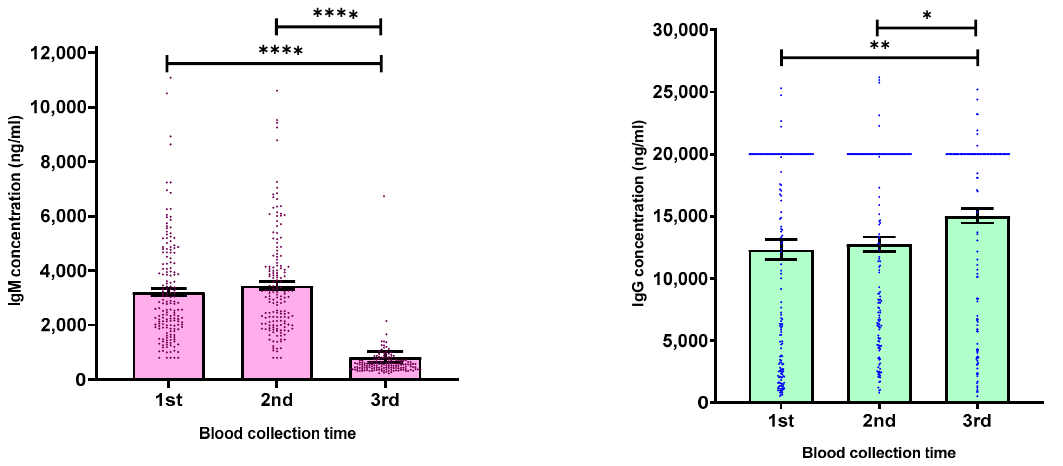
Figure 1. Levels of anti-spike IgM ( A ) and IgG antibodies ( B ) measured after three blood collection intervals. Concentration of specific antibodies against spike protein in peripheral blood of healthcare workers has been detected by commercially available ELISA kits (anti-spike IgM—( A ); anti-spike IgG—( B )). * p value 0.04, ** p value 0.009 and **** p < 0.0001.